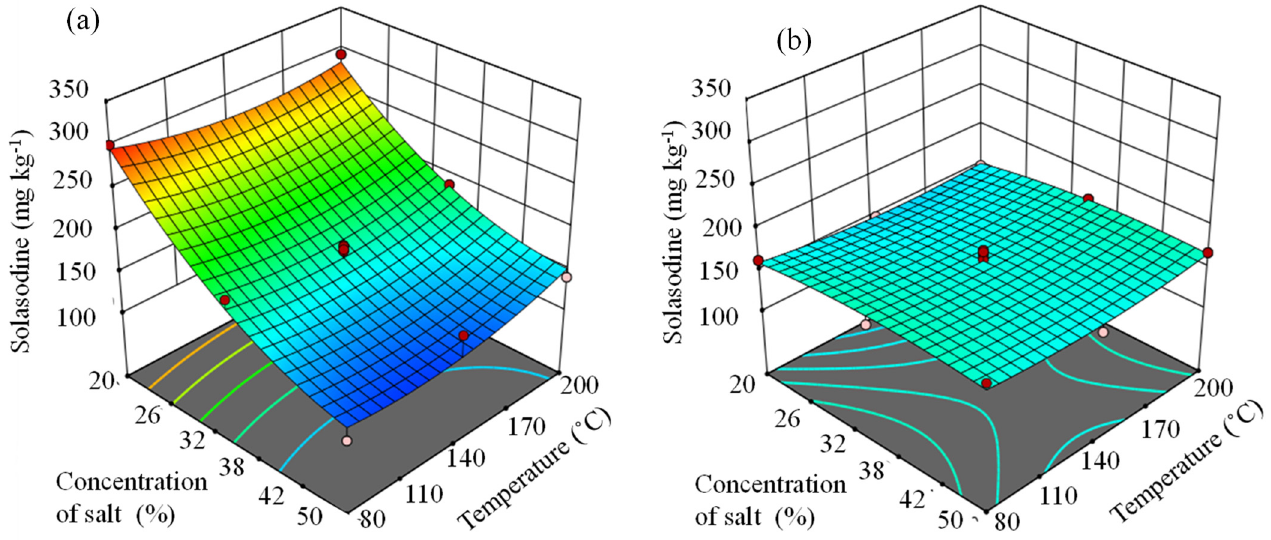
Figure 7. Response surfaces evaluating the effect of time and mass of plant powder in the presence of ( a ) Na 2 CO 3 and ( b ) NaCl on the extraction of solasodine.